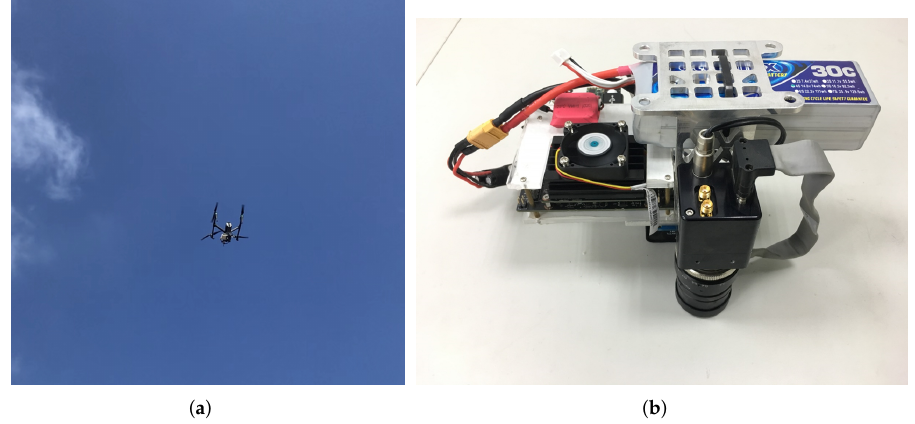
Figure 6. Prototype of the intelligent aerial remote-sensing system. ( a ) Drone flying using the proposed system. ( b ) The whole payload of the proposed